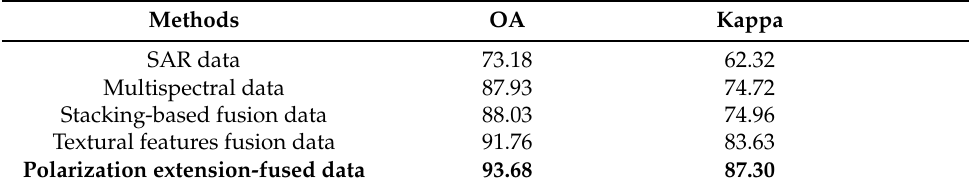
Figure 9. Classification results of the SVM using different datasets. ( a ) SAR data. ( b ) Multispectral data. ( c ) Stacking-based fusion data. ( d ) Textural feature fusion data. ( e ) Polarization extension-fused data. ( f – j ) The error maps of ( a – e ). Table 7. Contrast between the classification results before and after data